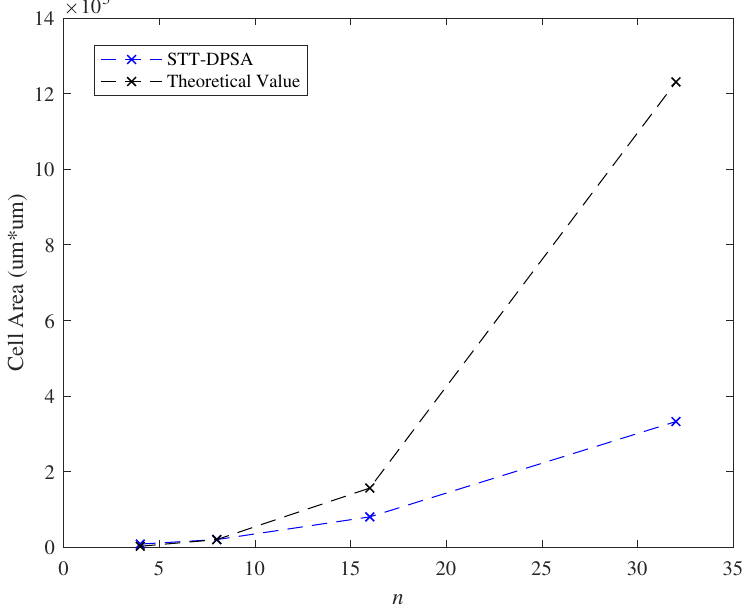
Figure 16. Effect of the parameter n with respect to the cell